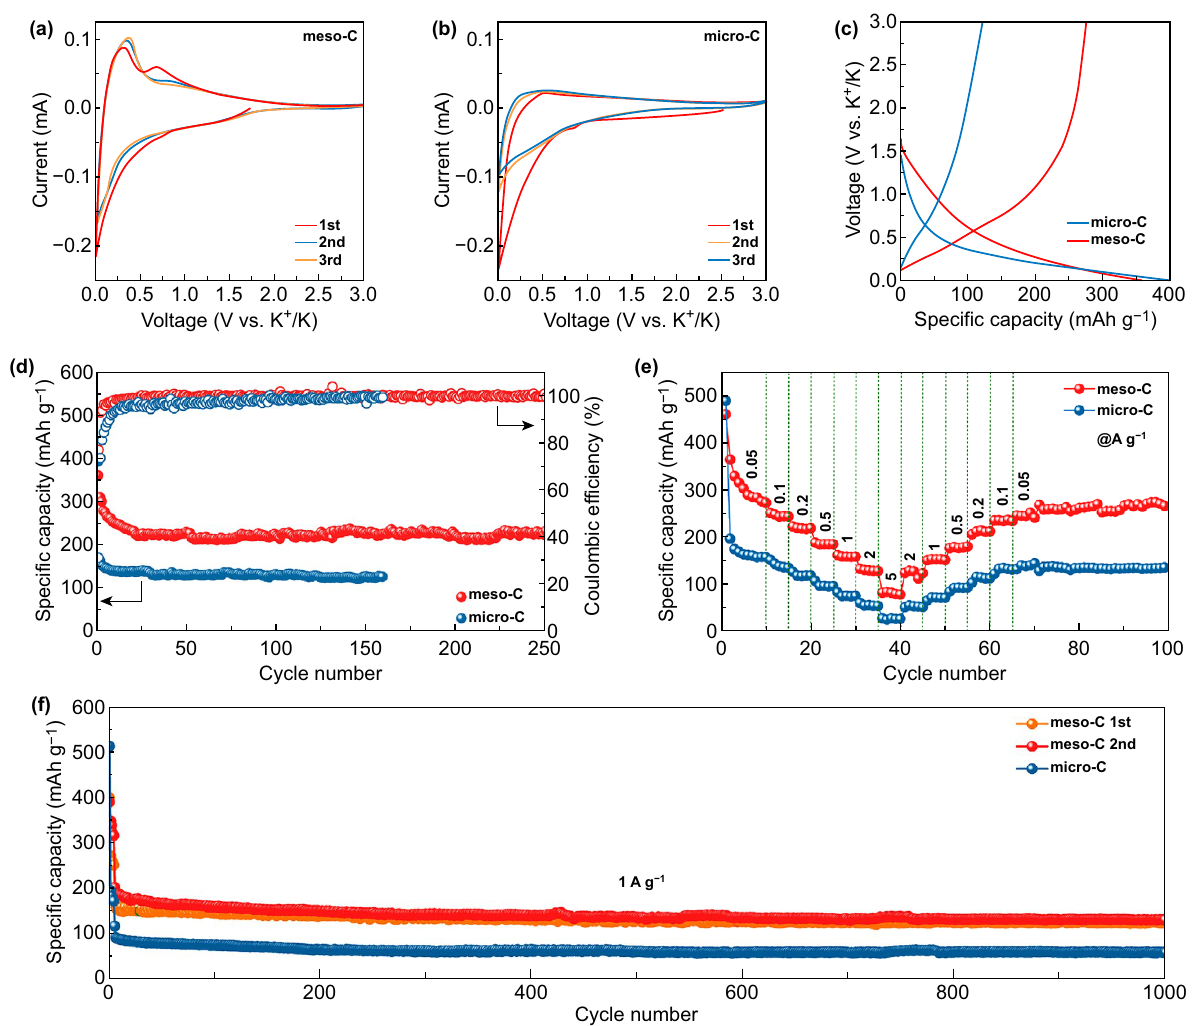
Fig. 3 K-storage performance. a , b CV curves of meso-C and micro-C at 0.1 mV s −1 in 0.01–3.0 V. c First charging/discharging profiles. d Cycling performance at 0.1 A g −1 and e rate performance. f Long-term cycling performance at 1 A g −1 after initial 5 cycles at 0.1 A g